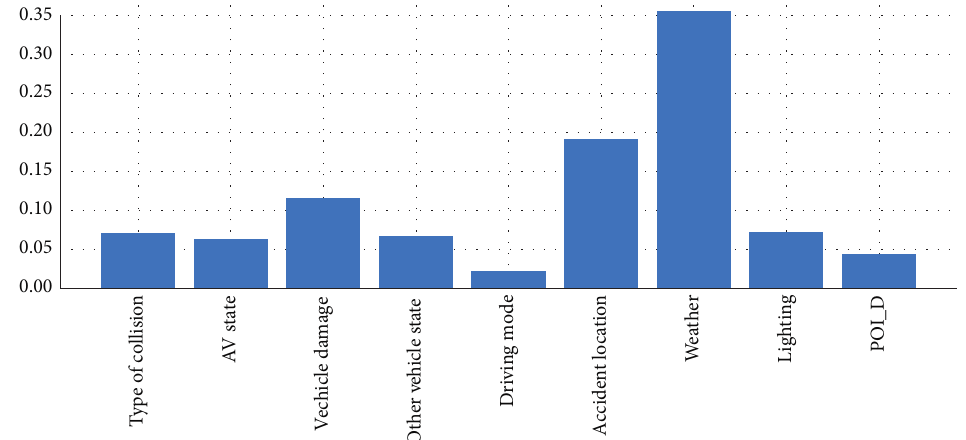
Figure 6: Feature